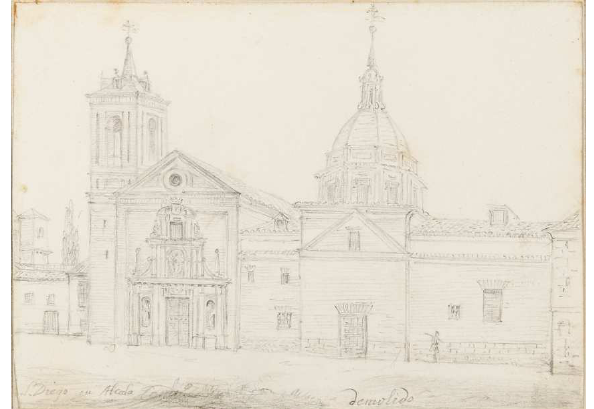
Figure 1: Facade of the demolished convent of San Diego.